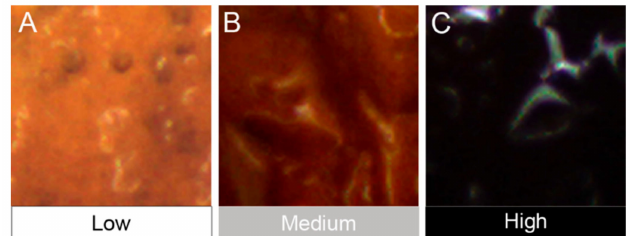
Figure 2. Qualitative starch evaluation according to a three-level color scale. ( A ): Low starch content (light brown). ( B ): Medium starch content (brown). ( C ): High starch content (dark grey-black). Samples were taken from flower primordia of apical buds of apple